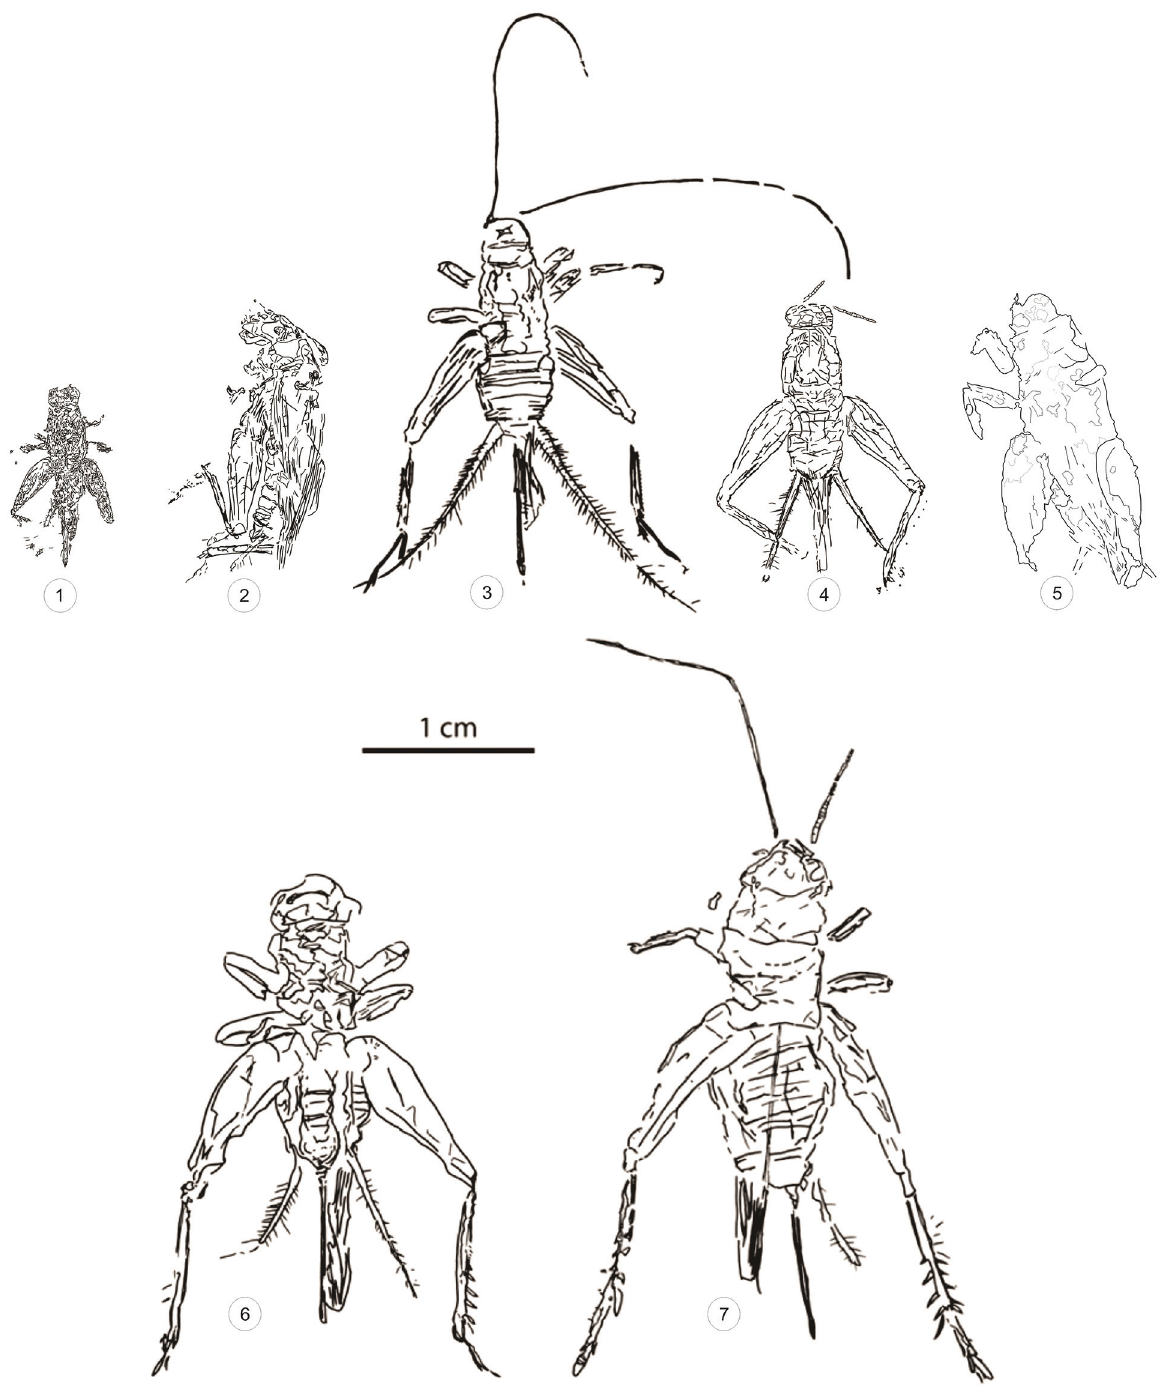
Figure 4 - Schematic drawings comparing the species – 1: Caririgryllus brachypterus, Martins Neto 2002; 2: